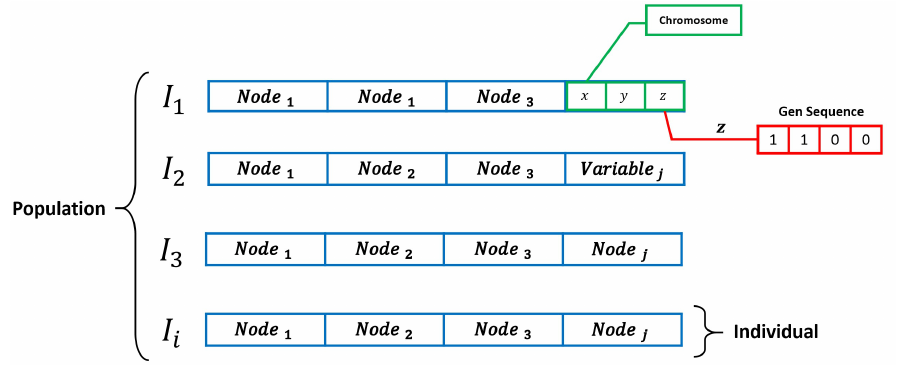
Figure 3. Binary codification of the GA for the Node Location Problem